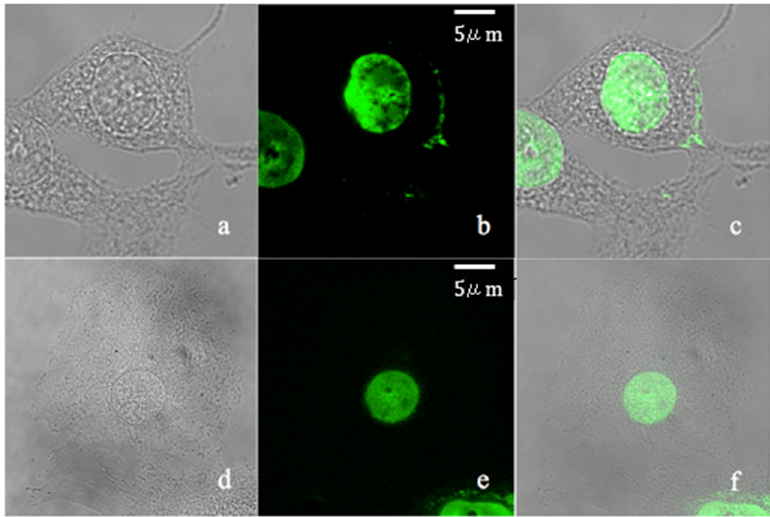
Figure 5. Visualization of the nucleus of SVG (non-tumoral) ( a – c ) and U-87 (tumoral) ( d – f ) cell lines with Compound 2 using confocal microscopy. Images are labeled as follows: ( a , d ) bright field; ( b , e ) fluorescence; and ( c , f ) merged images. Laser used 543 nm (green).